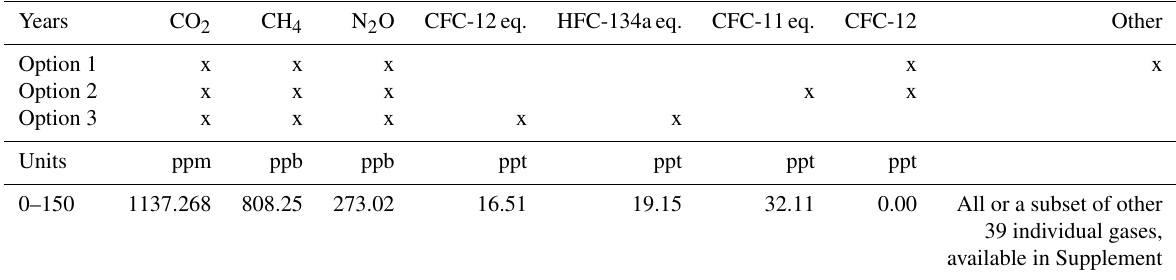
Figure 15. Comparison between the recommended annual global mean surface concentrations of CO 2 , CH 4 and N 2 O for CMIP5 and CMIP6 historical experiments. Table 10. abrupt4x: Global- and annual-mean surface concentrations for the idealized abrupt4x CMIP6 experiment. The hemispheric and latitudinally resolved concentrations for 43 GHGs and three aggregate equivalent concentrations are provided in the accompanying historical- run dataset, with the 1850 CO 2 concentration of 284.317 being multiplied by 4. The complexity reduction options for capturing all GHGs with fewer species than 43 are indicated in the table as Option 1, Option 2 and Option 3, with “x” denoting relevant columns under each